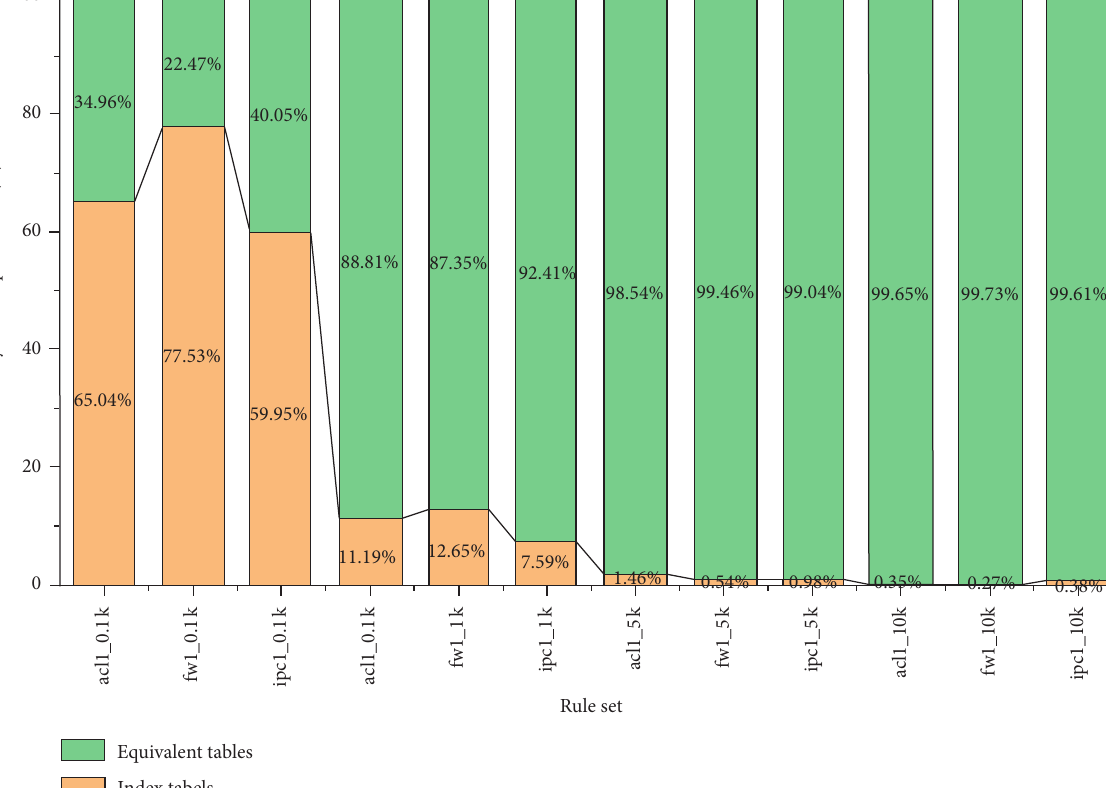
Figure 3: The memory consumption ratio for different rule